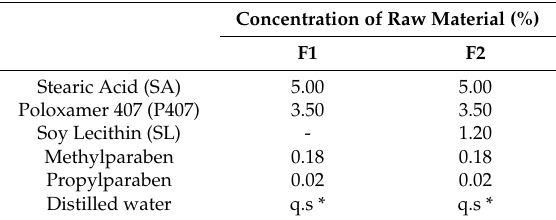
Table 1. SLN constituents.